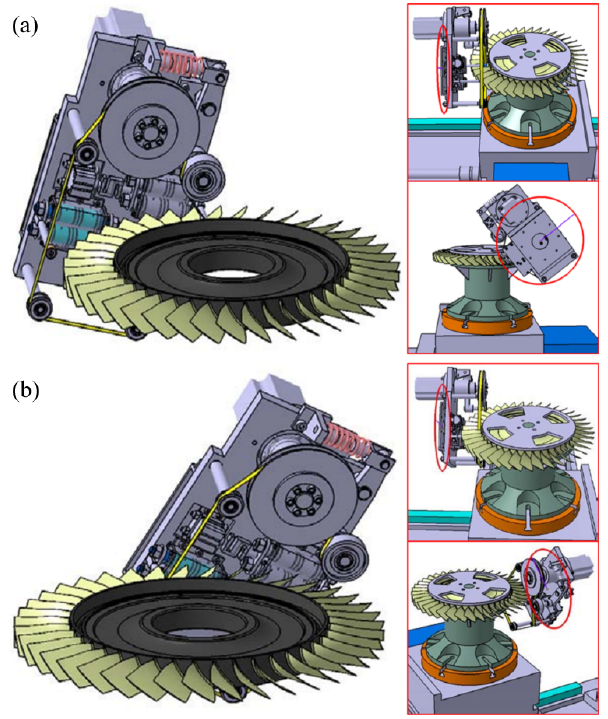
Figure 6. Drawing of the polishing concave side and convex side: (a) polishing the concave side of the blade and (b) polishing the convex side of the blade.